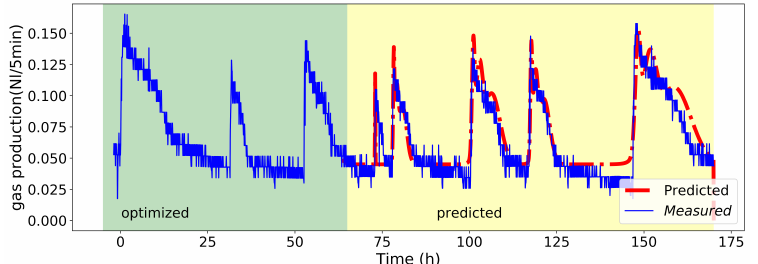
Figure 8. Prediction of gas production rates from 5 feeding events. The first three curves are used to optimize the Gaussian parameters (green). Based on the optimized values the following 5 curves are predicted